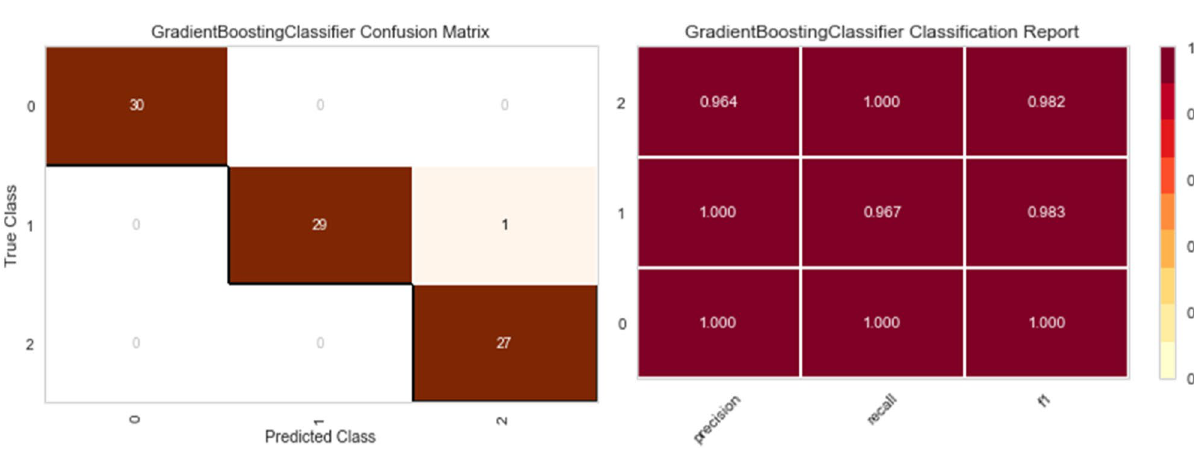
Figure 8. Matrix confusion and Report Classification of Gradient Boosting.